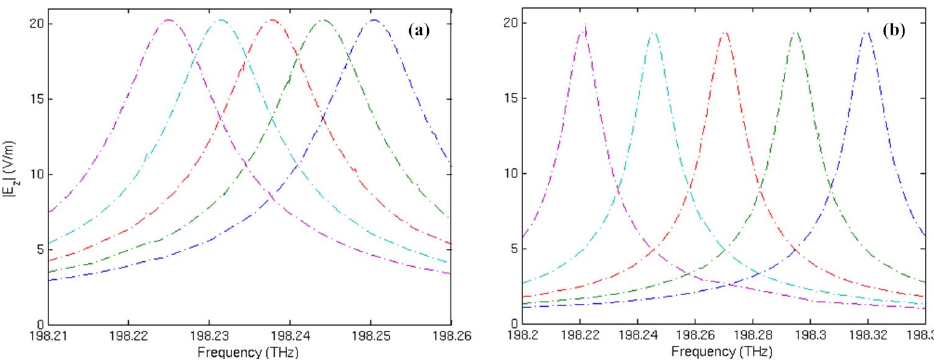
Figure 9. Resonant frequency spectrum of mode 27 with respect to the change of adsorbed substance permittivity ε . From left to right, the curves correspond to ε = 1.02, 1.04, 1.06, s s 1.08 and 1.1, respectively. (a) The traditional microring sensor. (b-f) show the simulation results of the metamaterial sensor with a metamaterial layer in the thickness of 0.06 μ m, 0.09 μ m, 0.12 μ m, 0.15 μ m, and 0.18 μ m respectively, attached to the inner